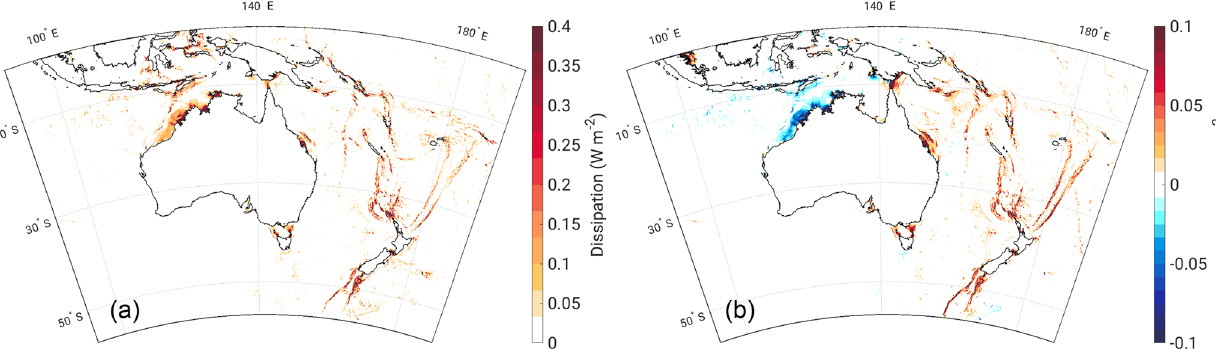
Figure 8. The dissipation (Wm − 2 ) associated with the M 2 constituent across the entire model domain (a) and the difference in dissipation between the 7m FL simulation and the control run (i.e. FL–control, b ).